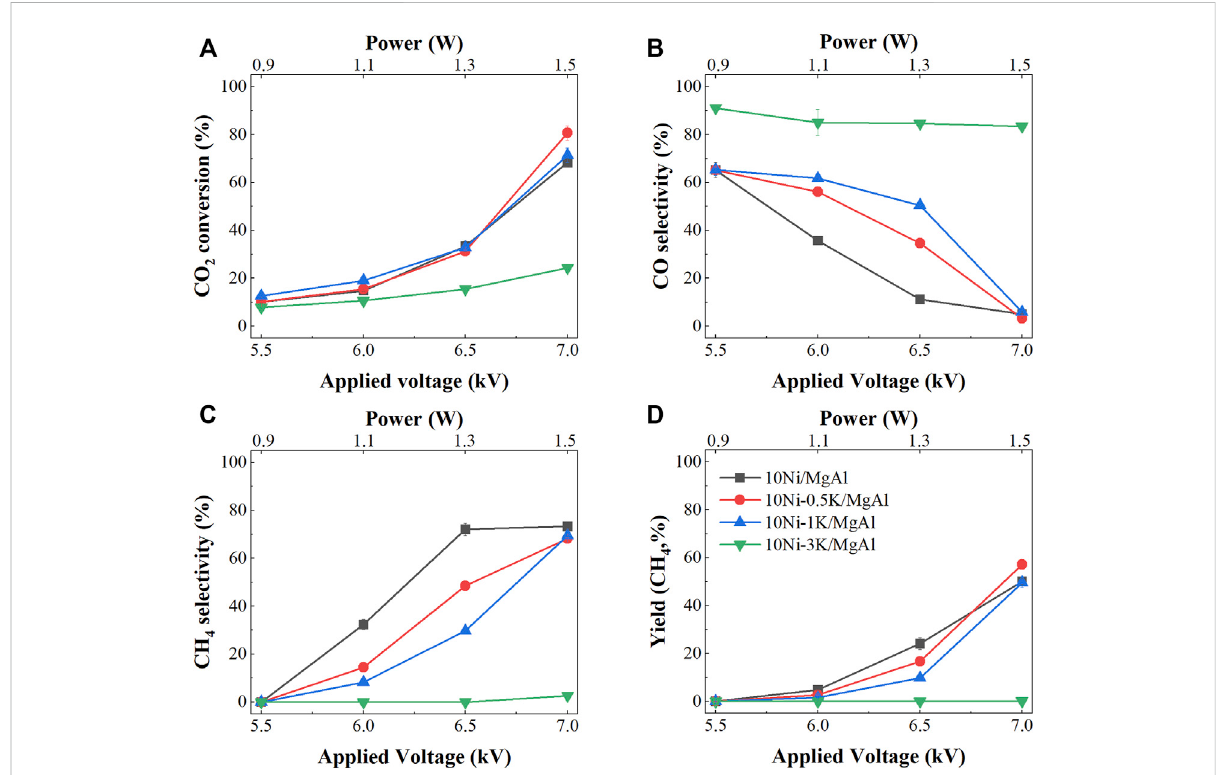
FIGURE 2 Performance of NTP-assisted CO 2 hydrogenation as a function of voltage over the 10Ni/MgAl system with different loadings of K; (A) CO 2 conversion, (B) CO selectivity, (C) CH 4 selectivity and (D) CH 4